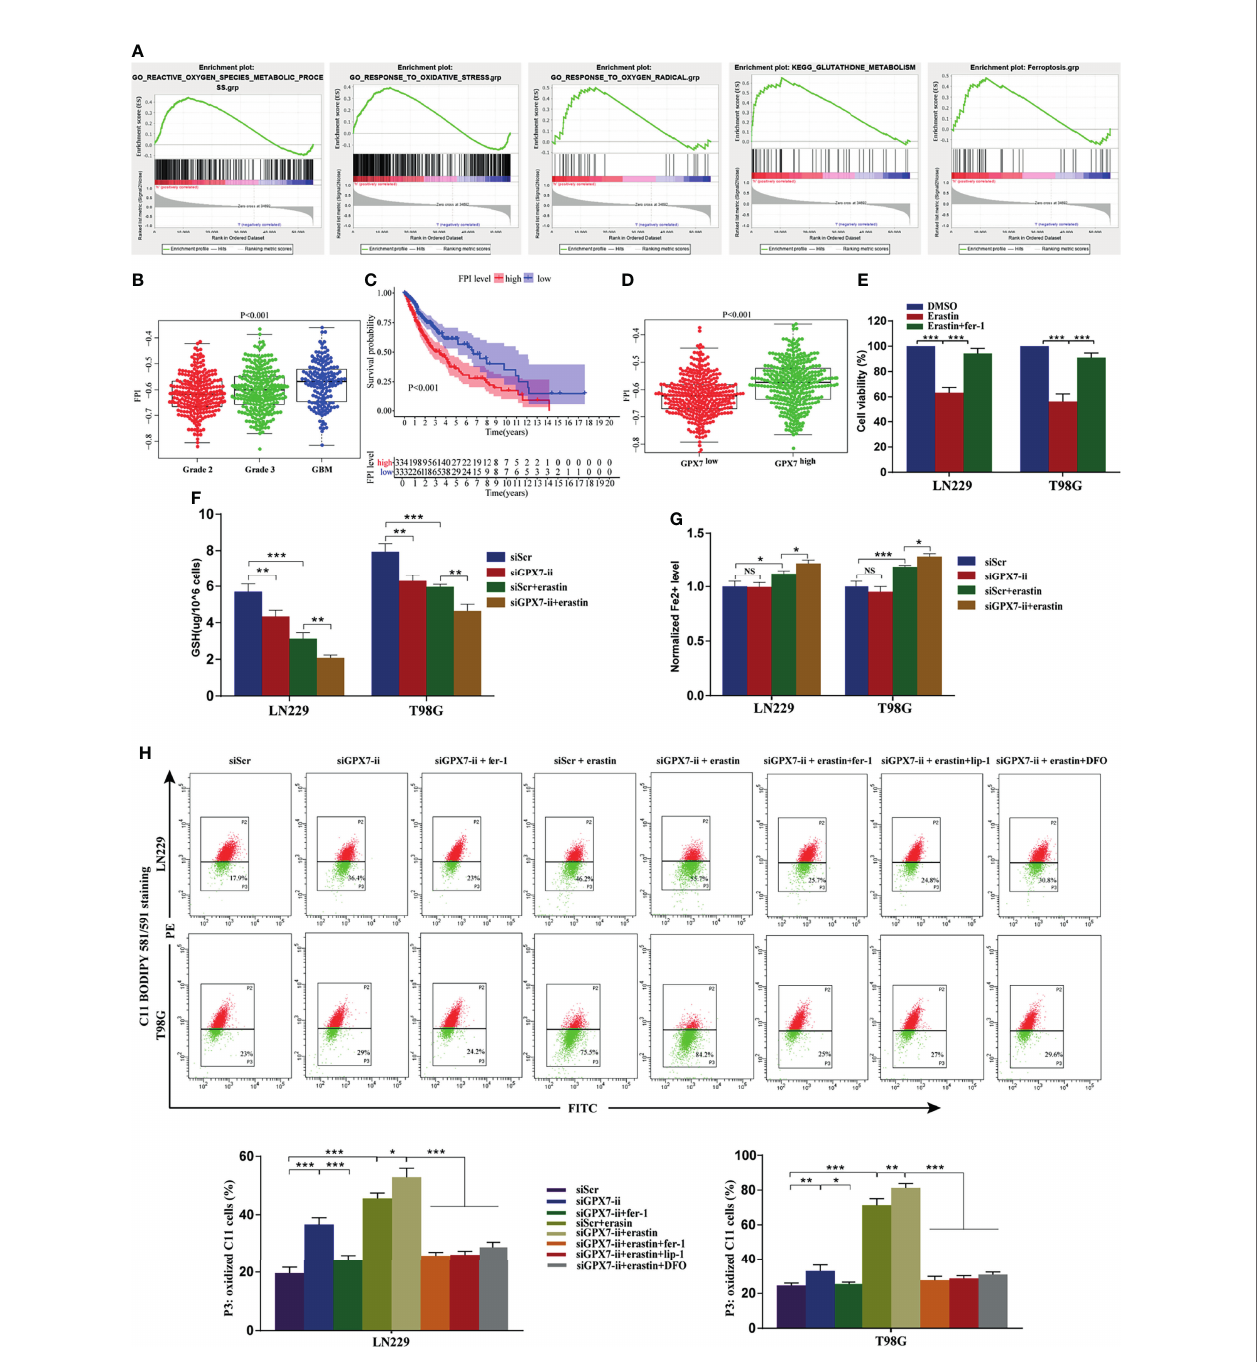
FIGURE 4 | The association of GPX7 and ferroptosis in glioma. (A – D) Bioinformatics analysis of the association of GPX7 and ferroptosis based on data from TCGA. (A) GSEA of ferroptosis and redox biology related gene sets in cohort with GPX7 high and low. (B) The different FPI levels among different WHO grades of glioma. (C) Kaplan-Meier analysis of OS according to the FPI level. (D) The association of GPX7 expression and FPI level in TCGA glioma samples. (E) CCK-8 assay was used to detect the cell viability of glioma cells treated with erastin (10 m M) for 24 h with or without fer-1 (2 m M). (F) The reduced GSH level in glioma cells subjected to siGPX7-ii transfection with or without erastin (10 m M) treatment. (G) The Fe2+ concentration was measured by FerroOrange probe. (H) Lipid peroxidation was detected in glioma cells subjected to siGPX7-ii transfection with or without fer-1 (2 m M), erastin (10 m M), lip-1 (100 nM) and DFO (100 m M) treatment, using C11 BODIPY 581/591 probe on fl ow cytometry. Within each chart, cells in P3 region in green represent those stained with oxidized dye. *P < 0.05, **P < 0.01, ***P < 0.001. ns, not signi fi